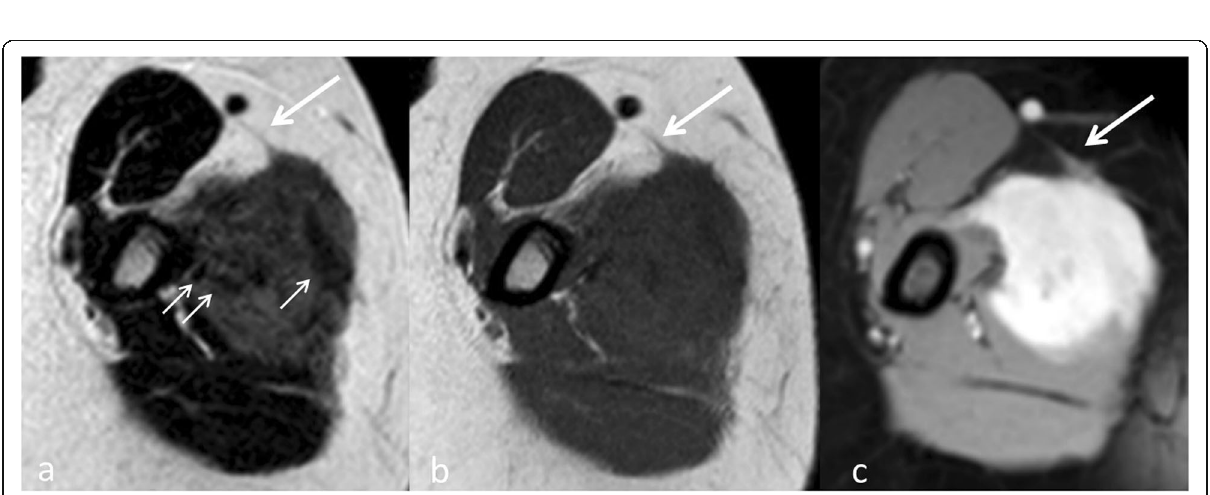
Fig. 2 Left arm fibromatosis presenting in a 39-year- old female; a axial T2, b axial T1, c axial post-contrast THRIVE showed the mass invading both the flexor and extensor compartments of the mid arm with low T2 signal bands (short arrows in a ) and fascial tail sign (long arrow in a , b , and c